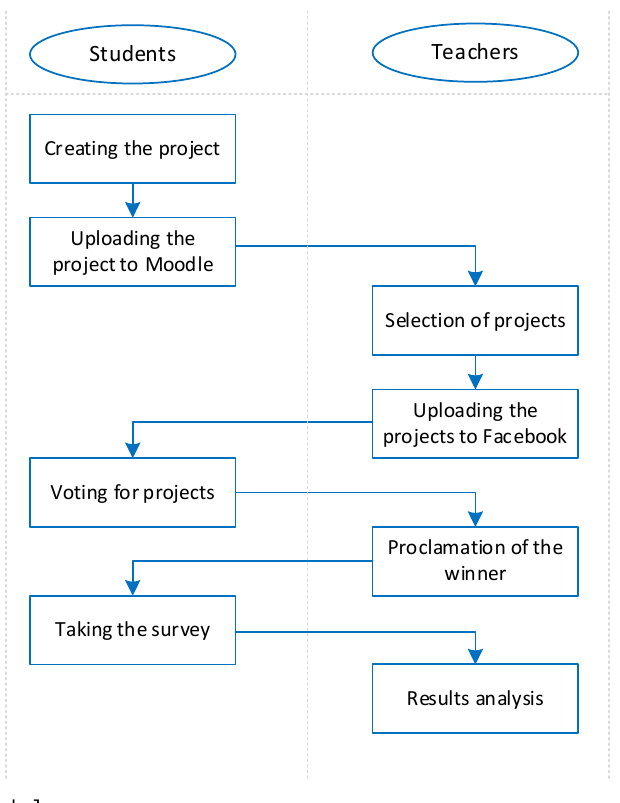
Figure 1 . Research